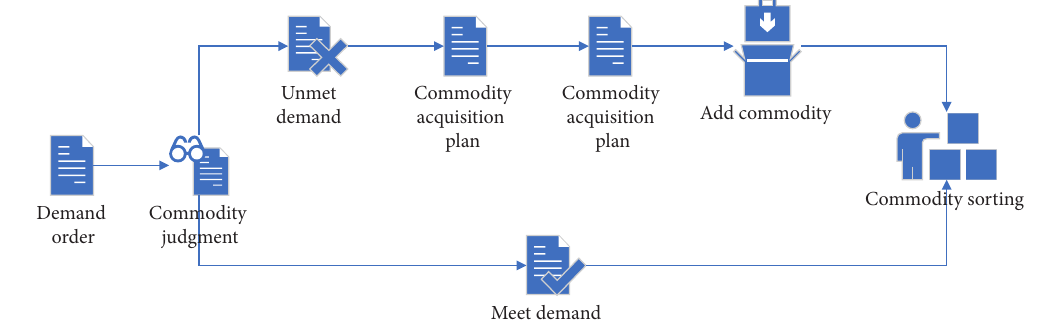
Figure 7: Receipt management process.